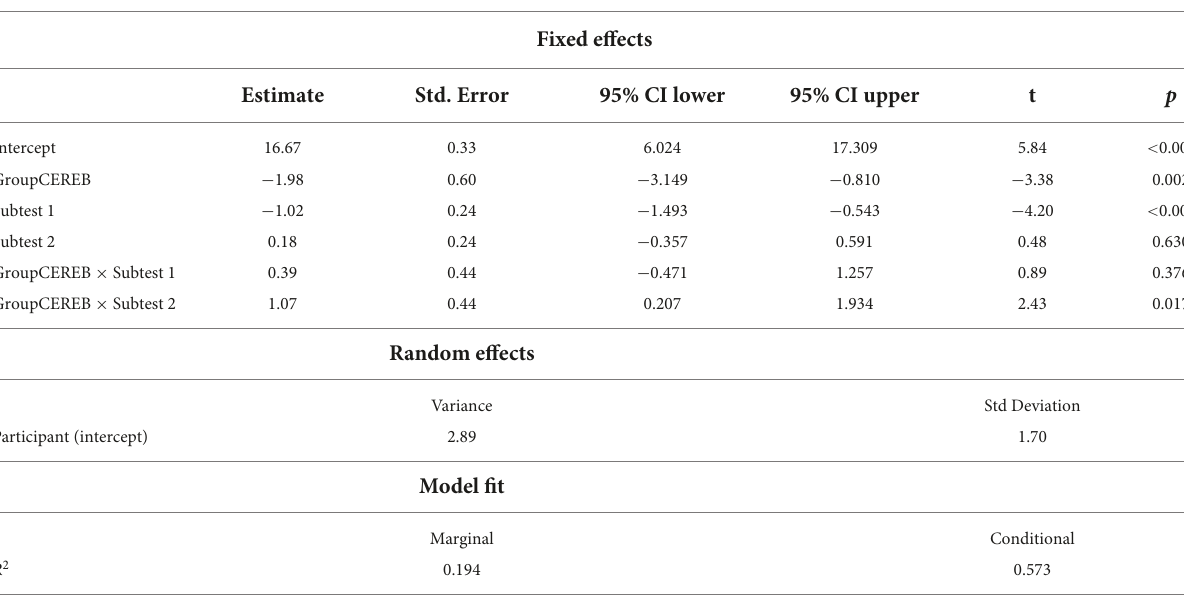
TABLE 1 Summary of the final linear mixed model for MBEMA